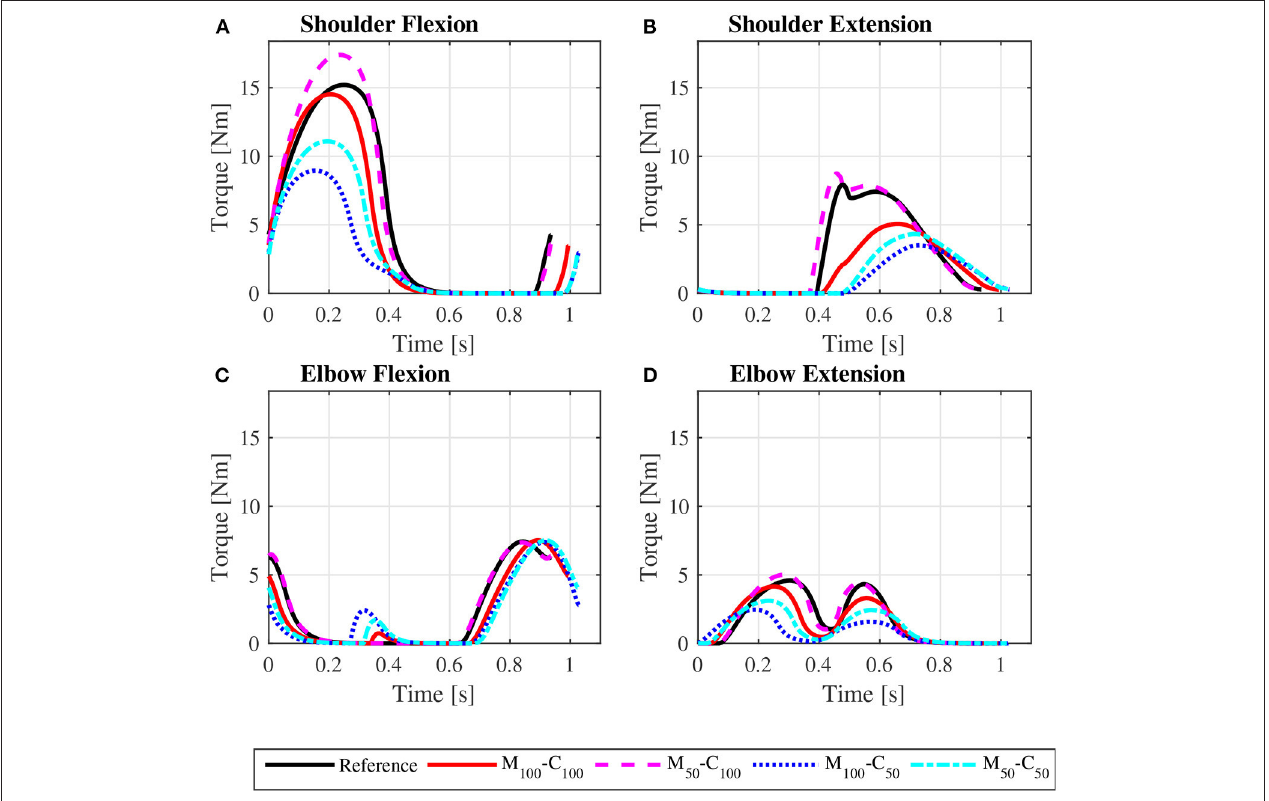
FIGURE 6 | Predicted bilateral shoulder flexion (A) , shoulder extension (B) , elbow flexion (C) , and elbow extension (D) torque profiles along a complete cycle for steady state locomotion on a level surface at an average speed of 0.9 m/s for the reference unassisted condition (Reference), and for the assisted locomotion with 100% of reference model parameters Mi and Ci ( M 100 − C 100 ), reduction of 50% in Mi ( M 50 − C 100 ), reduction of 50% in Ci ( M 100 − C 50 ), and reduction of 50% in Mi and Ci ( M 50 − C 50